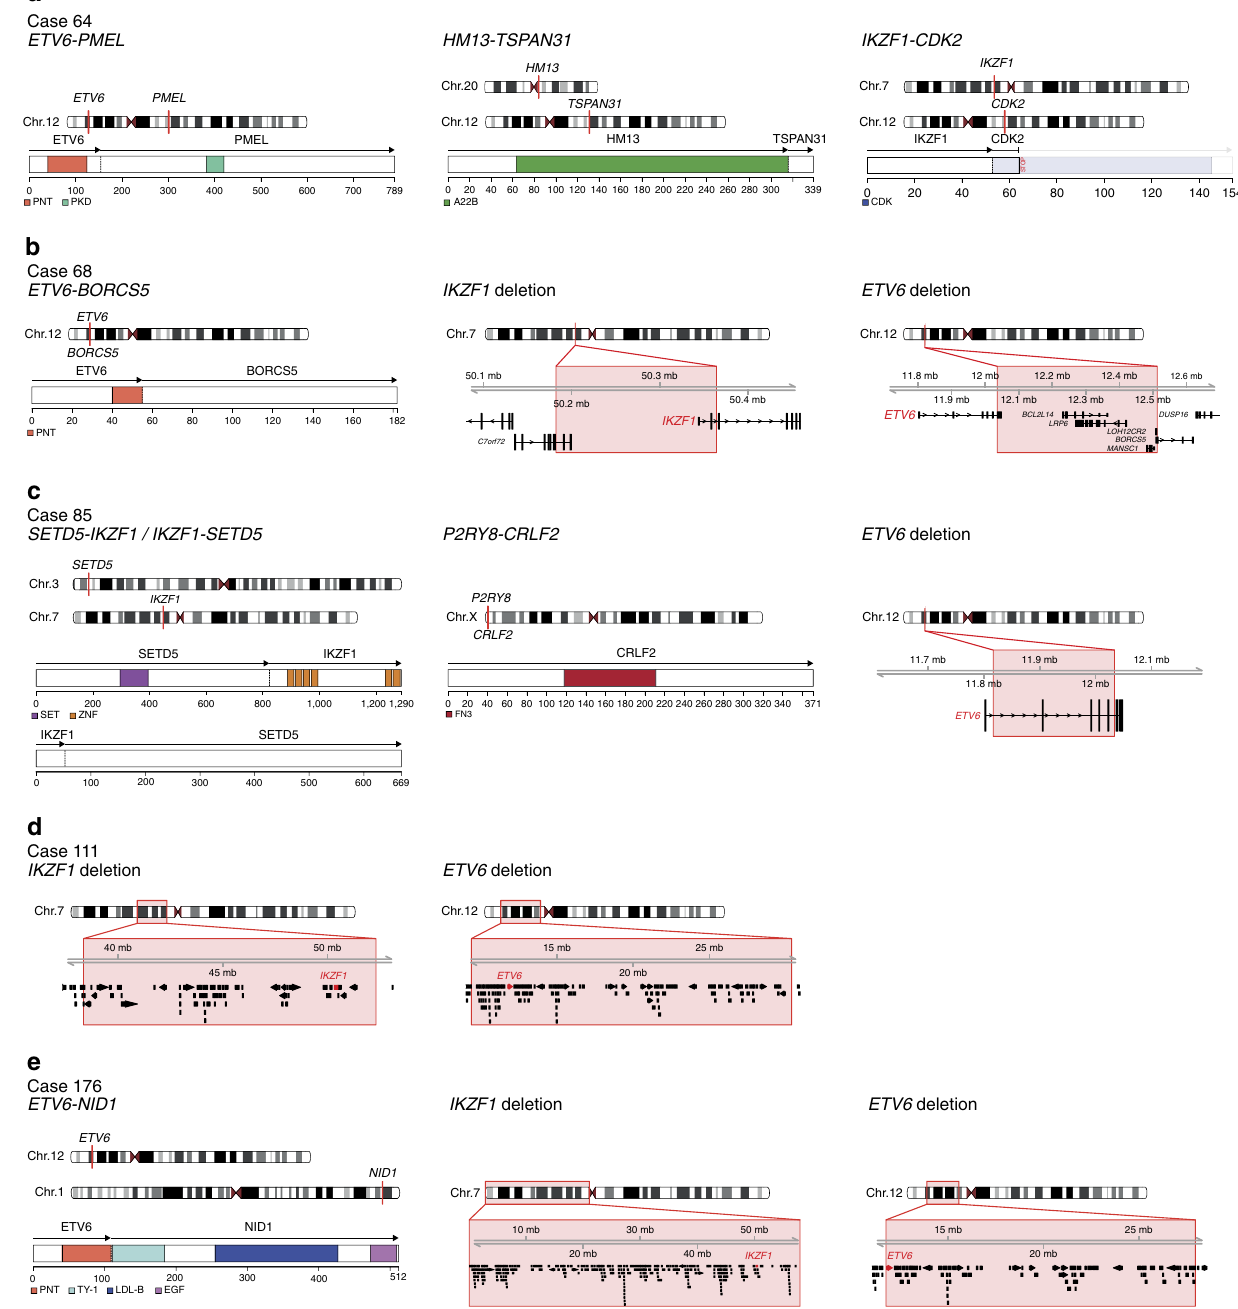
Figure 5 | Overview of aberrations in BCP ALL cases with ETV6-RUNX1 -like gene-expression pattern. The fusion genes are illustrated with a schematic overview of the chromosomal position of the genes involved in the fusion (top) and the retained protein domains together (bottom). Genomic deletions affecting ETV6 and IKZF1 are depicted with a red box indicating the deletion both at the chromosomal level and at the gene level, with ETV6 and IKZF1 in red. Illustrated protein domains: PNT, pointed domain; PKD, polycystic kidney disease domain; A22B, Peptidase A22B domain; CDK, protein kinase domain; SET, SET domain; ZNF, zinc-finger domain; FN3, fibronectin type-III domain; TY-1, thyroglobulin type-1 domain; LDL-B, LDL-receptor class B repeats; and EGF, EGF-like domain. ( a ) Gene fusions present in case 64. No SNP array data were available for this case. IKZF1-CDK2 is an out-of-frame fusion, with no functional domains from CDK2 being included in the fusion protein. ( b ) Gene fusions and deletions present in case 68. The breakpoints of the ETV6 deletion are within ETV6 and BORCS5 ; likely representing the event that created the ETV6-BORCS5 fusion gene. The breakpoints of the IKZF1 deletion occur within the C7orf72 and IKZF1 genes, but RNA-seq data did not indicate the presence of a fusion transcript of these genes. ( c ) Gene fusions and deletions present in case 85. The P2RY8-CRLF2 fusion does not contain any coding features from P2RY8 but leads to overexpression of the entire coding region of CRLF2 . ( d ) Deletions present in case 111. No gene fusions were detected in this case. ( e ) Gene fusions and deletions present in case